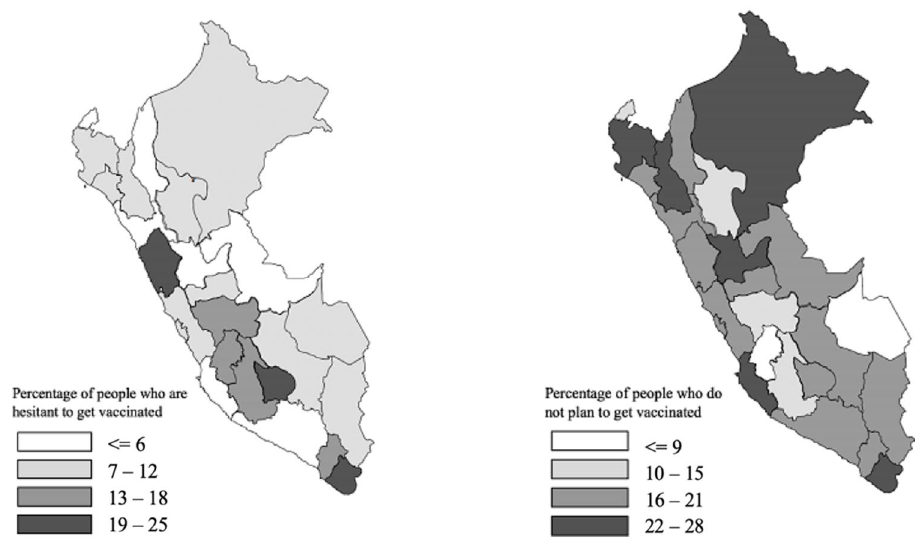
Figure 2. Geographical distribution of people that are hesitant or do not plant to get vaccinated in Peru.